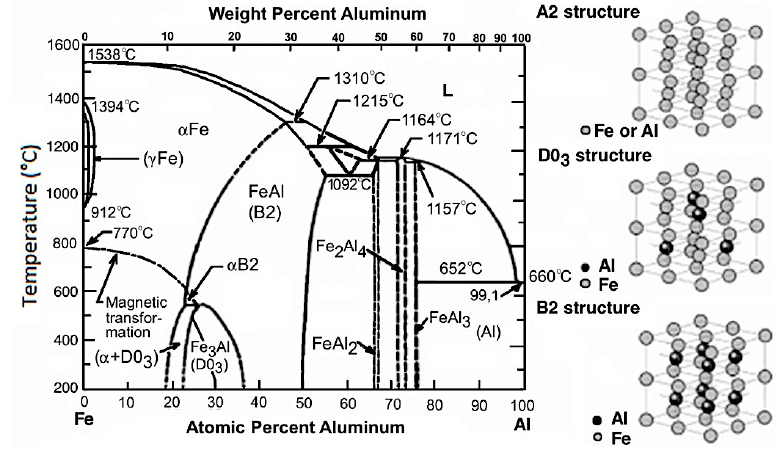
Figure 1. Fe-Al equilibrium system and elementary cells of A2, D03 and B2 structures.